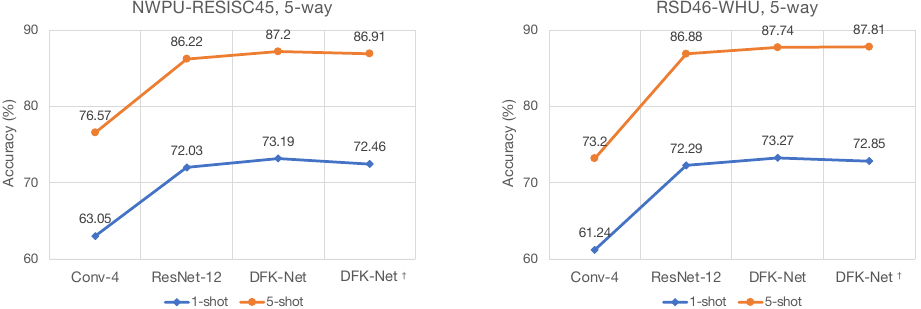
Figure 9. Few-shot classification accuracy of our model using different embedding networks on the NWPU-RESISC45 and RSD46-WHU